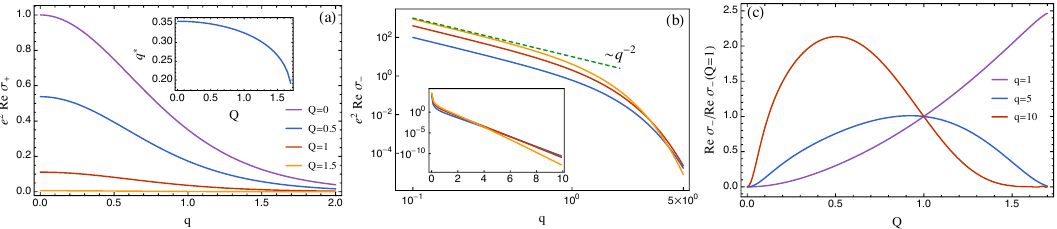
Figure 8: Spectral weight at finite desnity. (a): σ + against q for various Q . Inset shows the critical q ∗ from the WKB limit. (b): σ − against q for Q = 0.5,1,1.5. All the curves scale as q − 2 at small q . Inset shows that the exponential decay at large q depends on Q . The dependence is more clear in (c), where the normalized σ − becomes non-monotonic against Q for large q